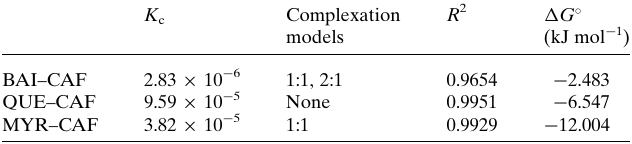
Table 2 Cocrystal formation constant ( K c ), complexation models and Gibbs free energy ( (cid:2) G (cid:2) ) of the three cocrystals. K